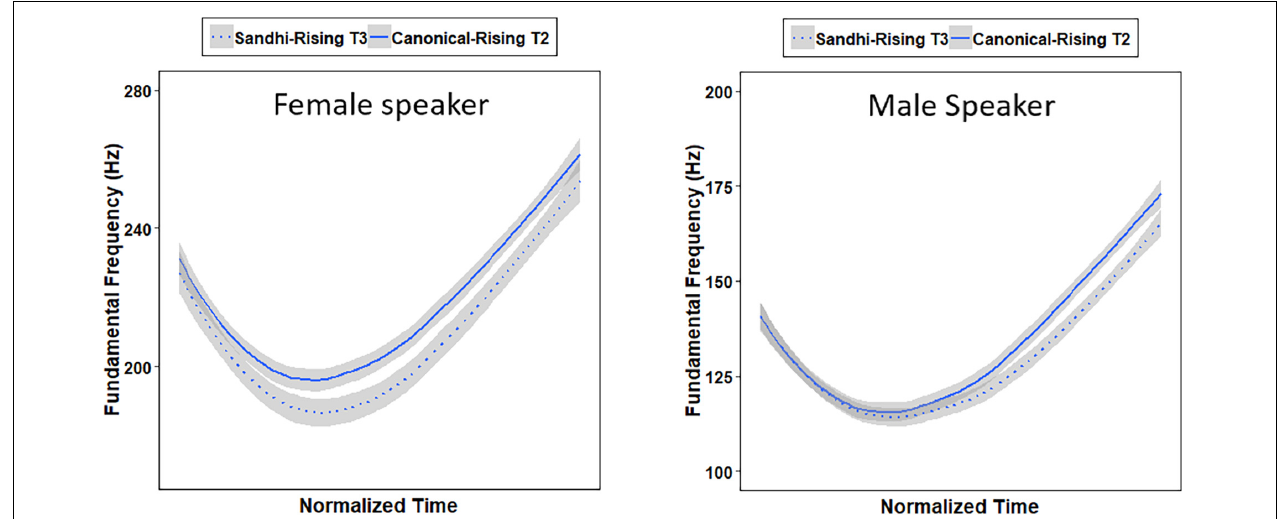
FIGURE 2 | Mean F0 tracks of the Sandhi-Rising T3 and Canonical-Rising T2 syllables for the female (left panel) speaker and male (right panel) speaker.